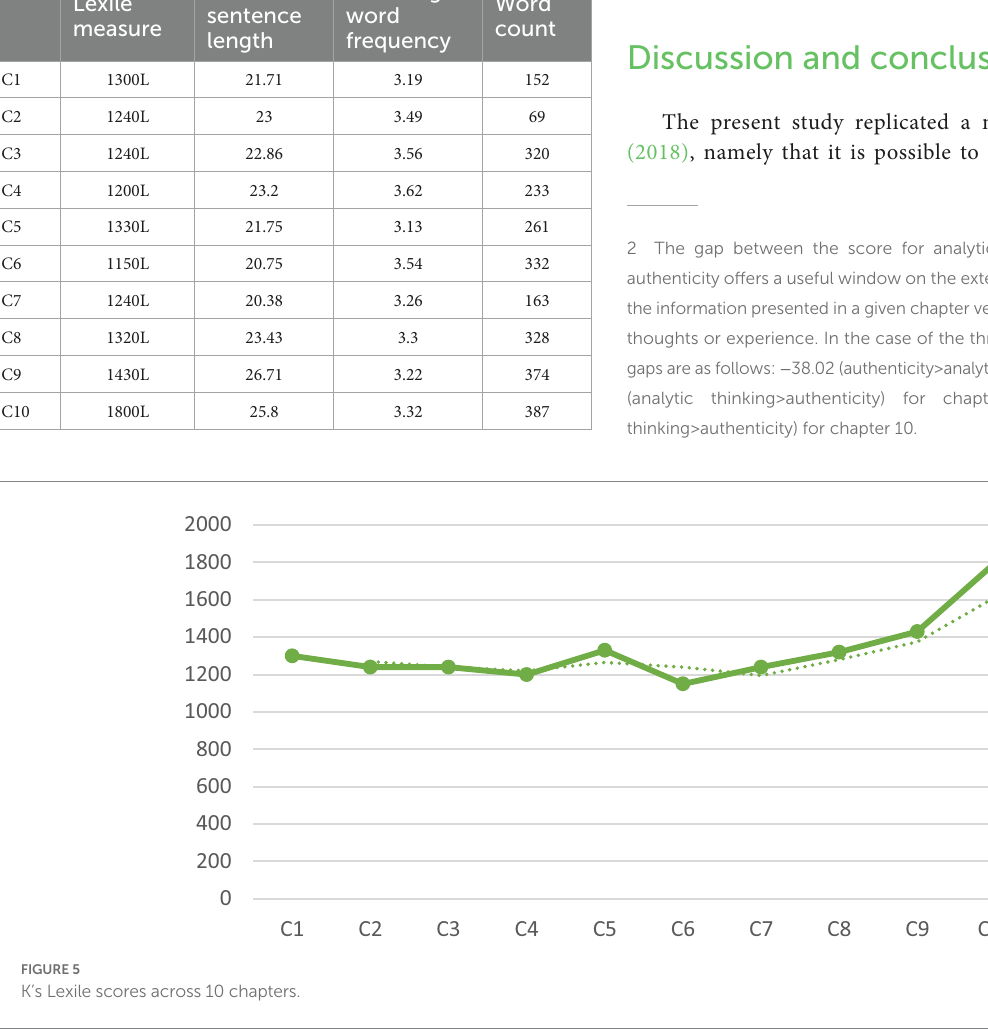
TABLE 5 K’s scores across 10 chapters from the Lexile analyses. Lexile measure